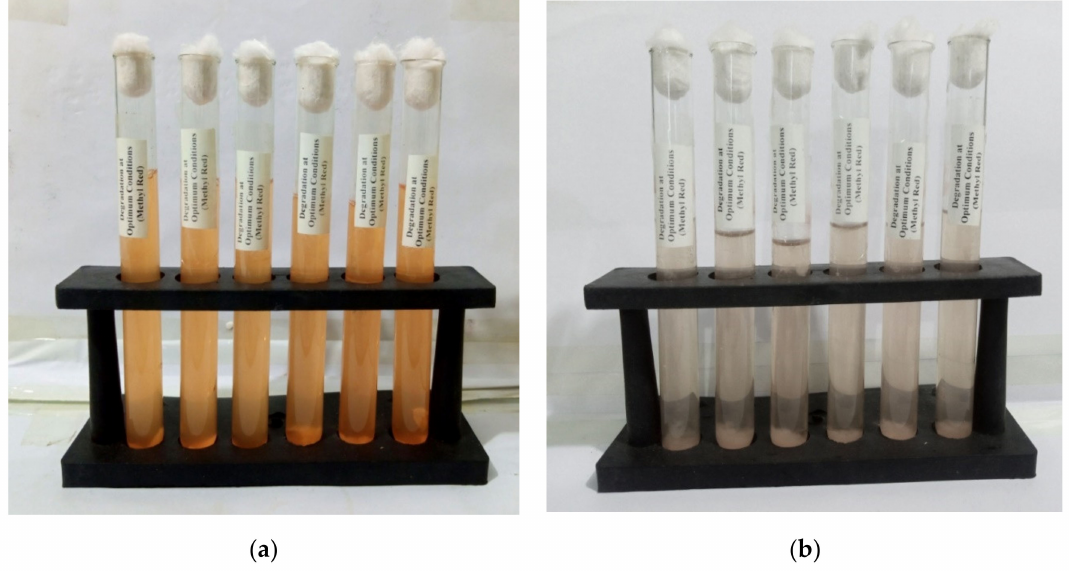
Figure 10. Methyl red dye ( a ) before treatment and ( b ) after treatment of P. aeruginosa